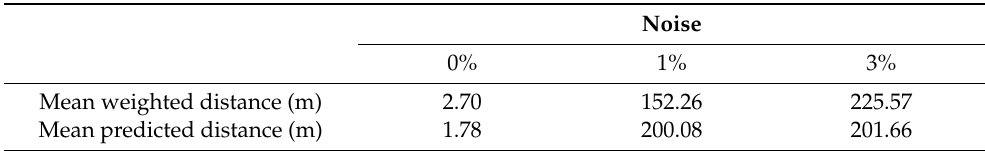
Table 12. Inference mean values for node 20, with